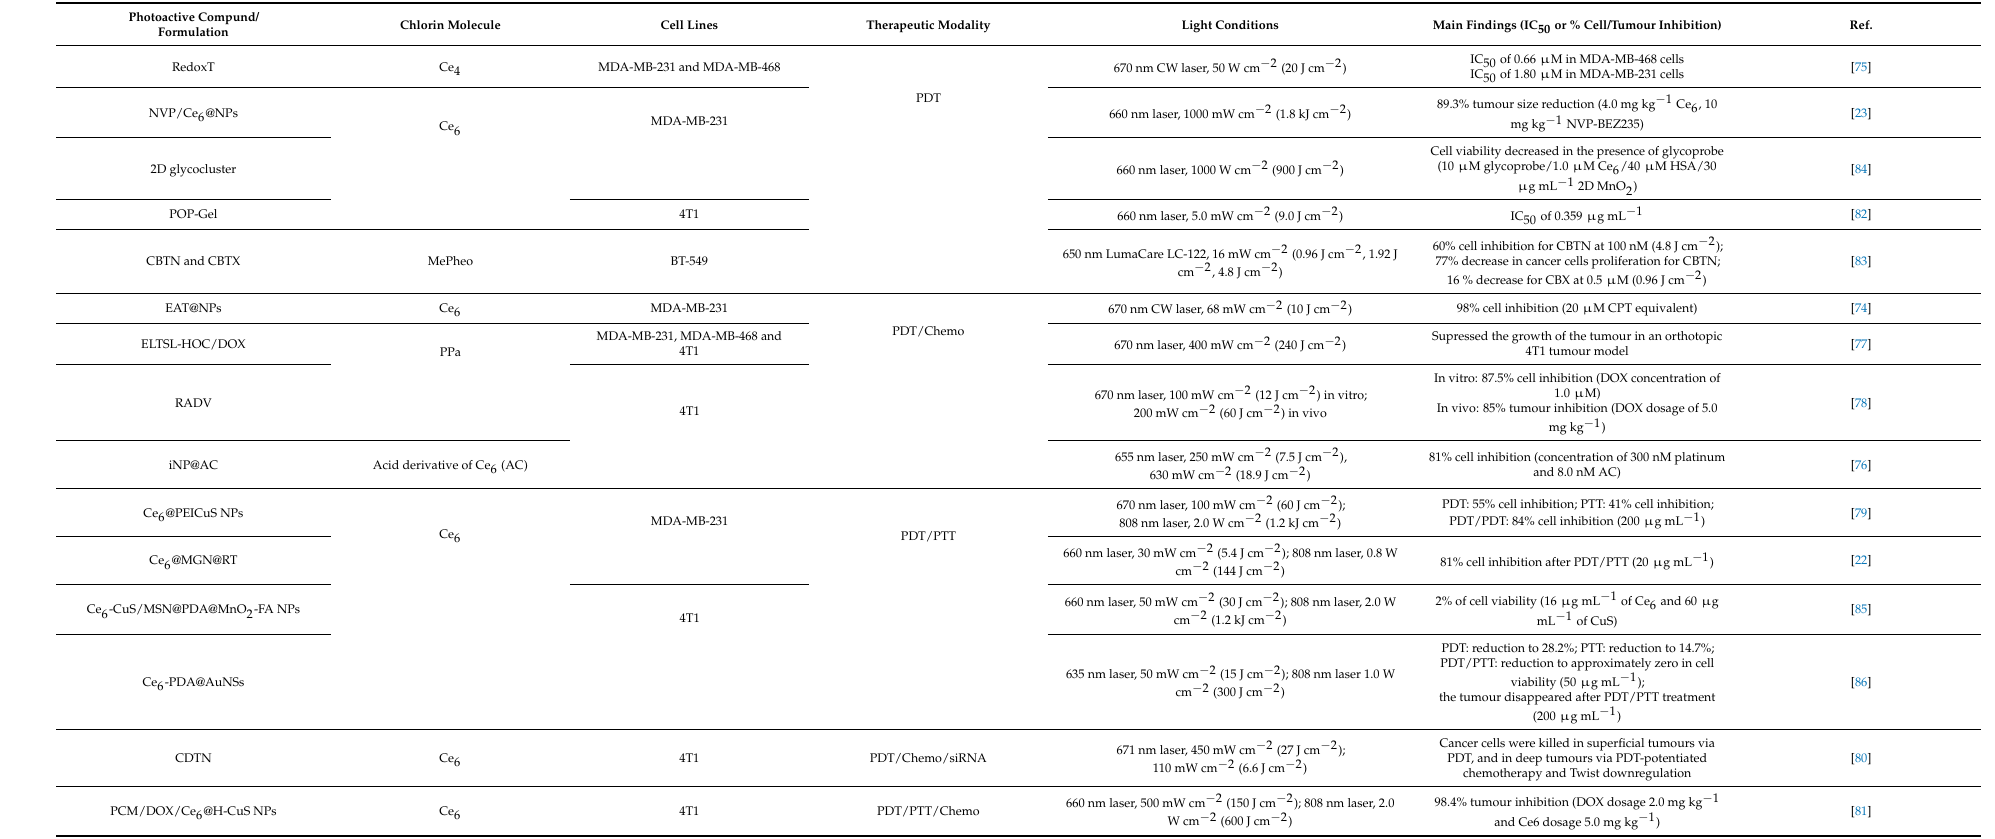
Table 1. Summarized studies with the different chlorin photoactive